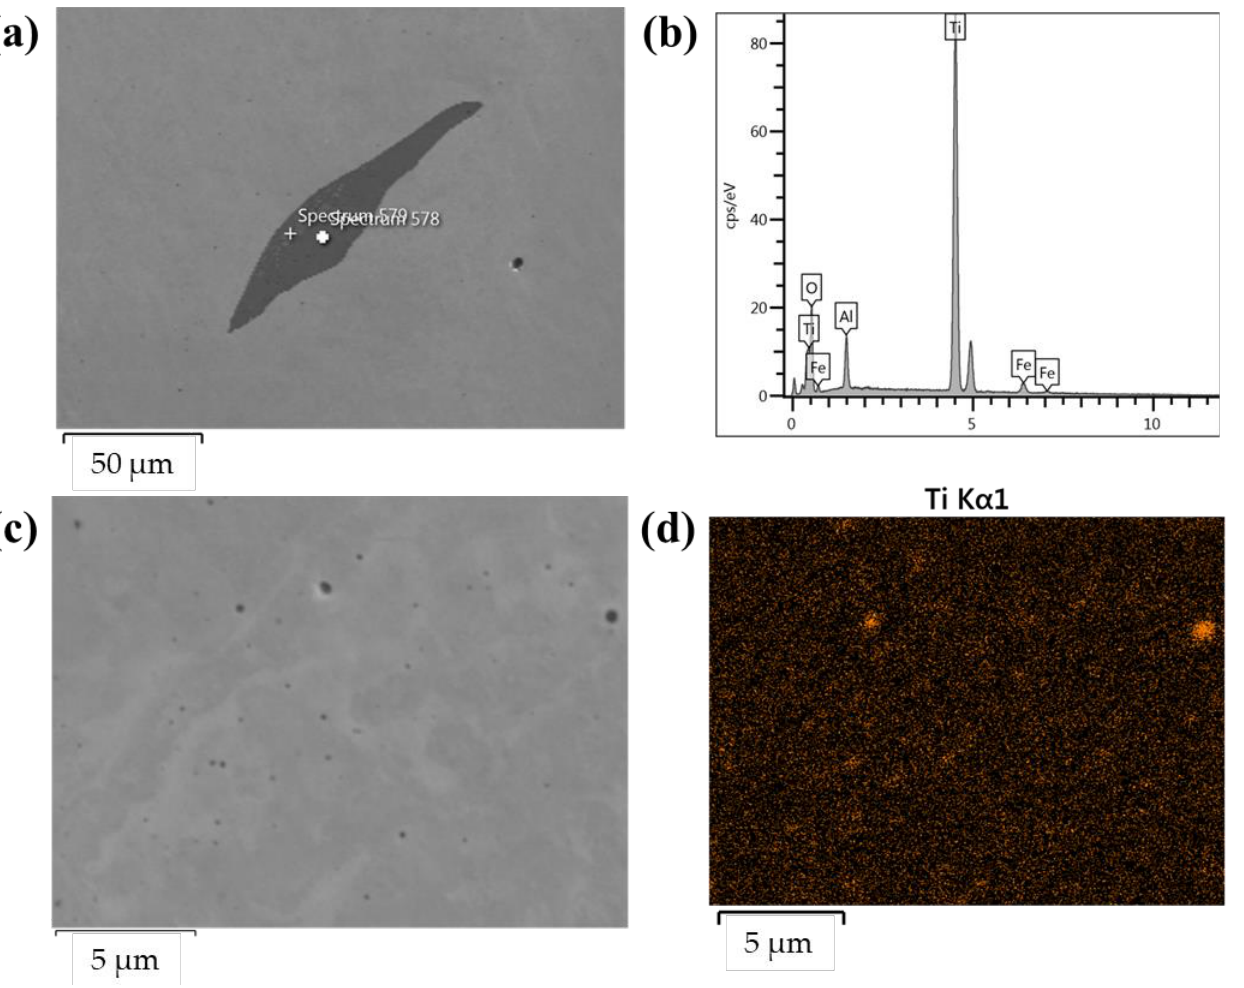
Figure 7. SEM analysis of precipitated particles in the as-coated specimen. ( a ) SEM image of precipitated particles and ( b ) spectral distribution of chemical species, Ti particles dispersion after heat treatment, ( c ) SEM image of Ti particles dispersion and ( d ) EDX scan map of Ti particles distribution.